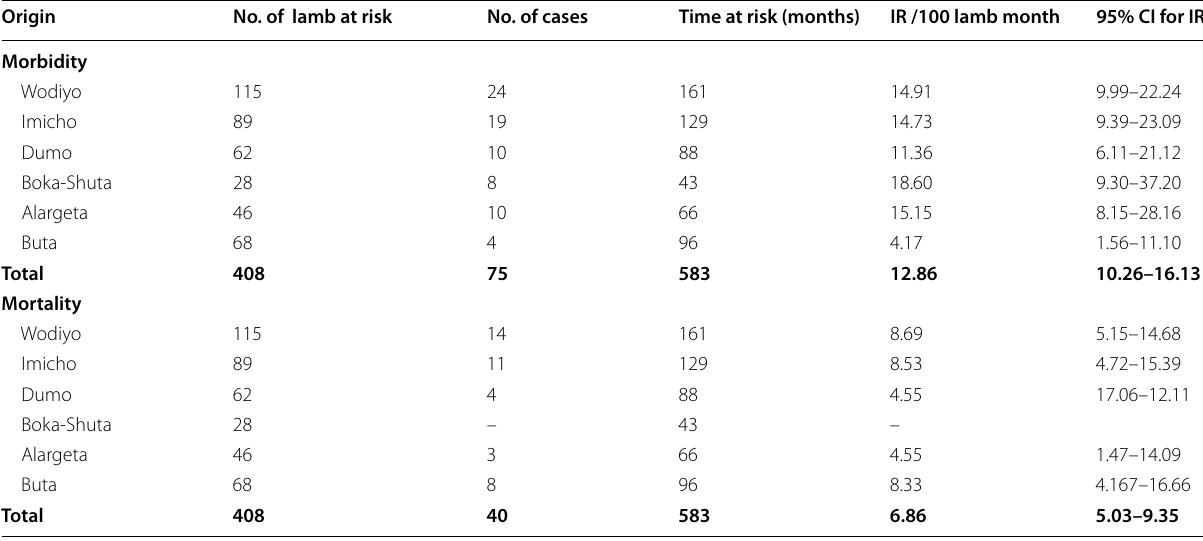
IR Incidence rate, CI Confidence Interval